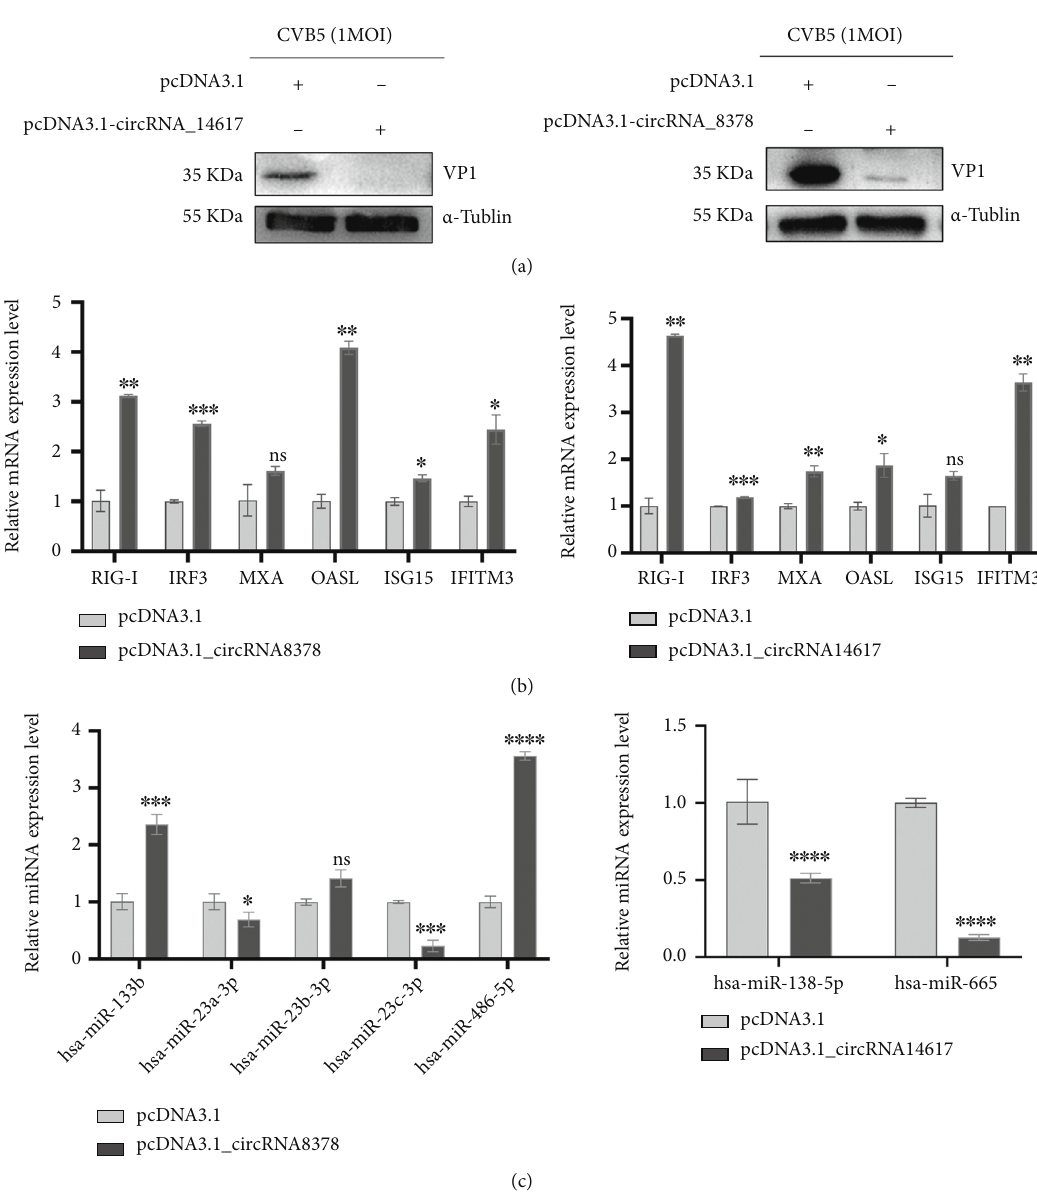
Figure 6: Veri fi cation of circRNA hsa_circ_0008378 and novel_circ_0014617. (a) Western blot analysis of CVB5 speci fi c protein VP1 expression transfected with pcDNA3.1-circRNAs. (b) RT-qPCR detected the expression of genes in IFN-I pathways (RIG-I, IRF3, MxA, OSAL, ISG15, and IFITM3). (c) RT-qPCR detected the expression of target miRNA according to the network. Data are representative of three independent experiments with similar results. Data are shown as mean ± SD (b) and (c). Ns, not signi fi cant, ∗ p < 0 : 05 , ∗∗ p < 0 : 01 , ∗∗∗ p < 0 : 001 , and ∗∗∗∗ p < 0 : 0001 , two-tailed unpaired Student ’ s t